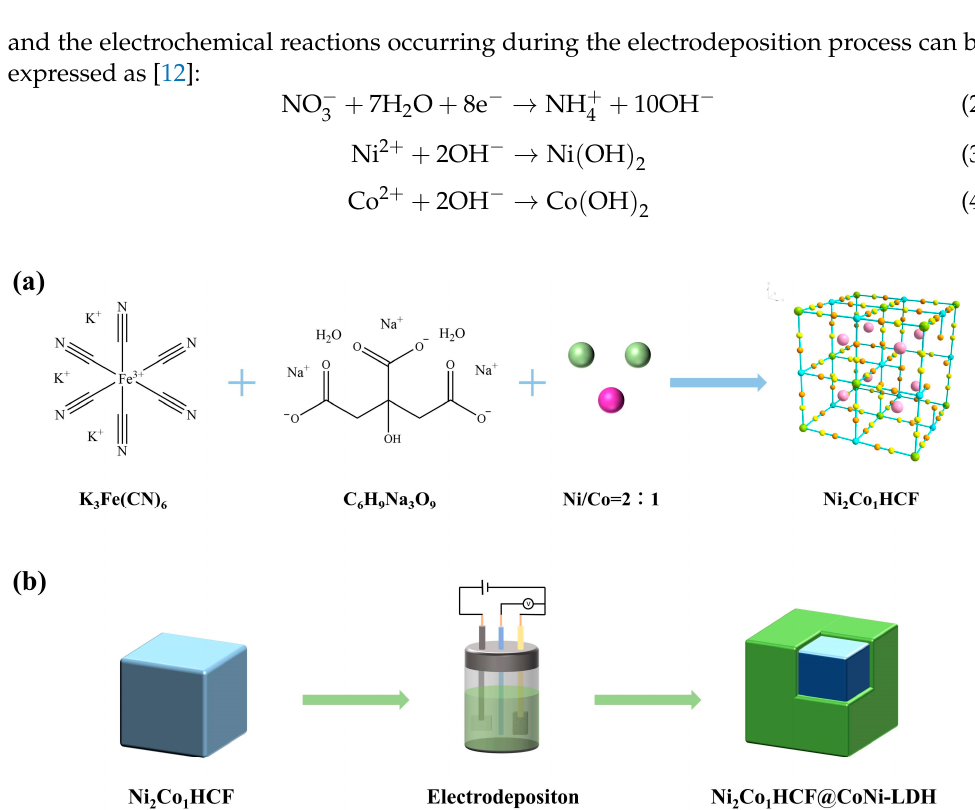
Figure 1. Schematic illustration of synthesizing ( a ) Ni 2 Co 1 HCF; ( b ) Ni 2 Co 1 HCF@CoNi-LDH/NF.